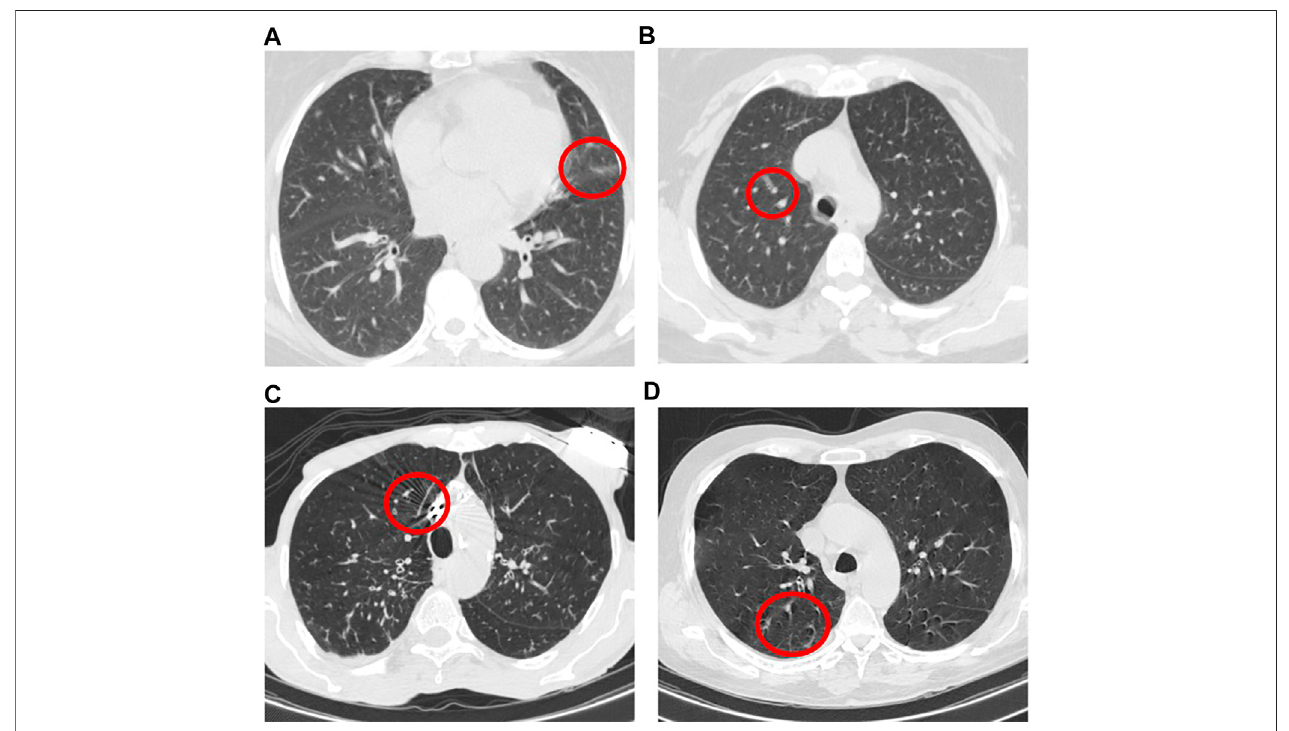
FIGURE 8 | Example of slices with the evidence of artifact where no infection manifestation